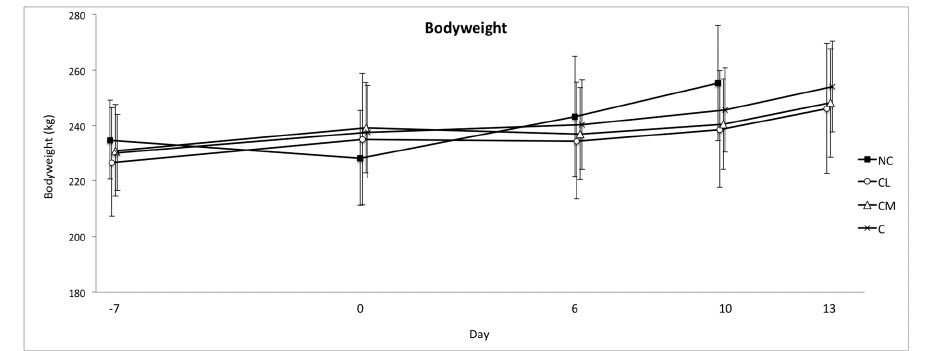
Figure 1. Mean (±SD) bodyweight (kg) of Bos indicus bull calves from − 7 (7 days prior to surgery) to 13 days after surgery. NC = no castration, CL = castration with lidocaine, CM = castration with meloxicam, C = castration without analgesia.